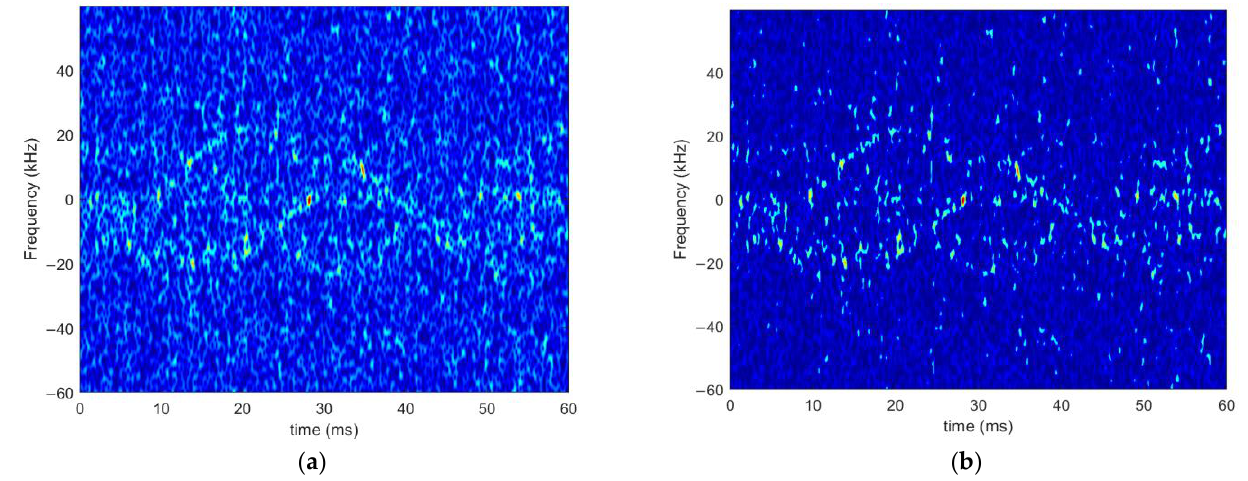
Figure 12. Time – frequency distribution of turbine echo (SNR = 0 dB): ( a ) Before enhancement of wavelet coefficients. ( b ) After enhancement of wavelet coefficients.